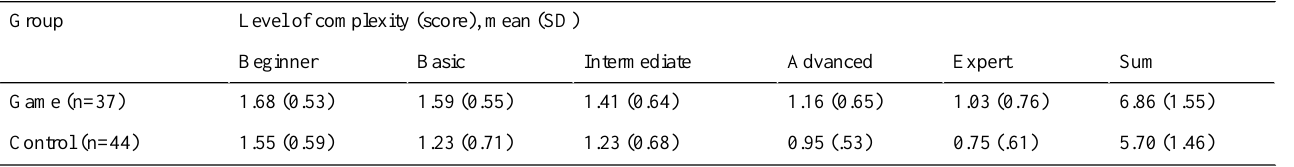
Table 3. Descriptive results from study 1. Level of complexity (score), mean (SD)Group